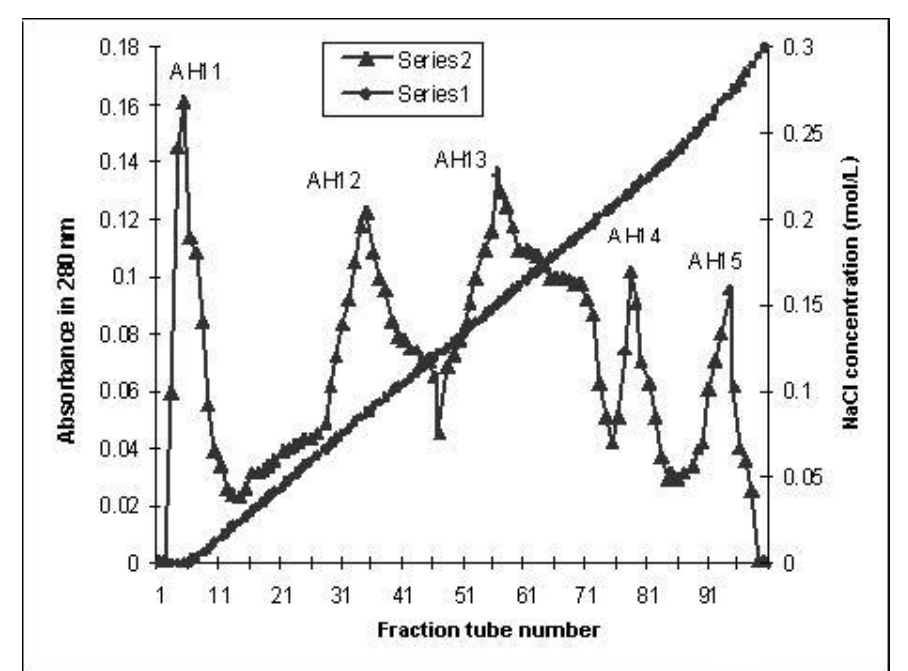
Figure 2 . DEAE-Sepharose chromatography of AH1 fraction obtained from Sephadex G-50. The pooled fractions from Figure 1 were applied to DEAE- Sepharose column (2.5 x 20 cm) equilibrated with 0.05 M Tris-HCl buffer (pH 8.2). Proteins were eluted with a linear concentration gradient of NaCl from 0 to 0.5 M and 4.5-mL fractions per tube were collected.